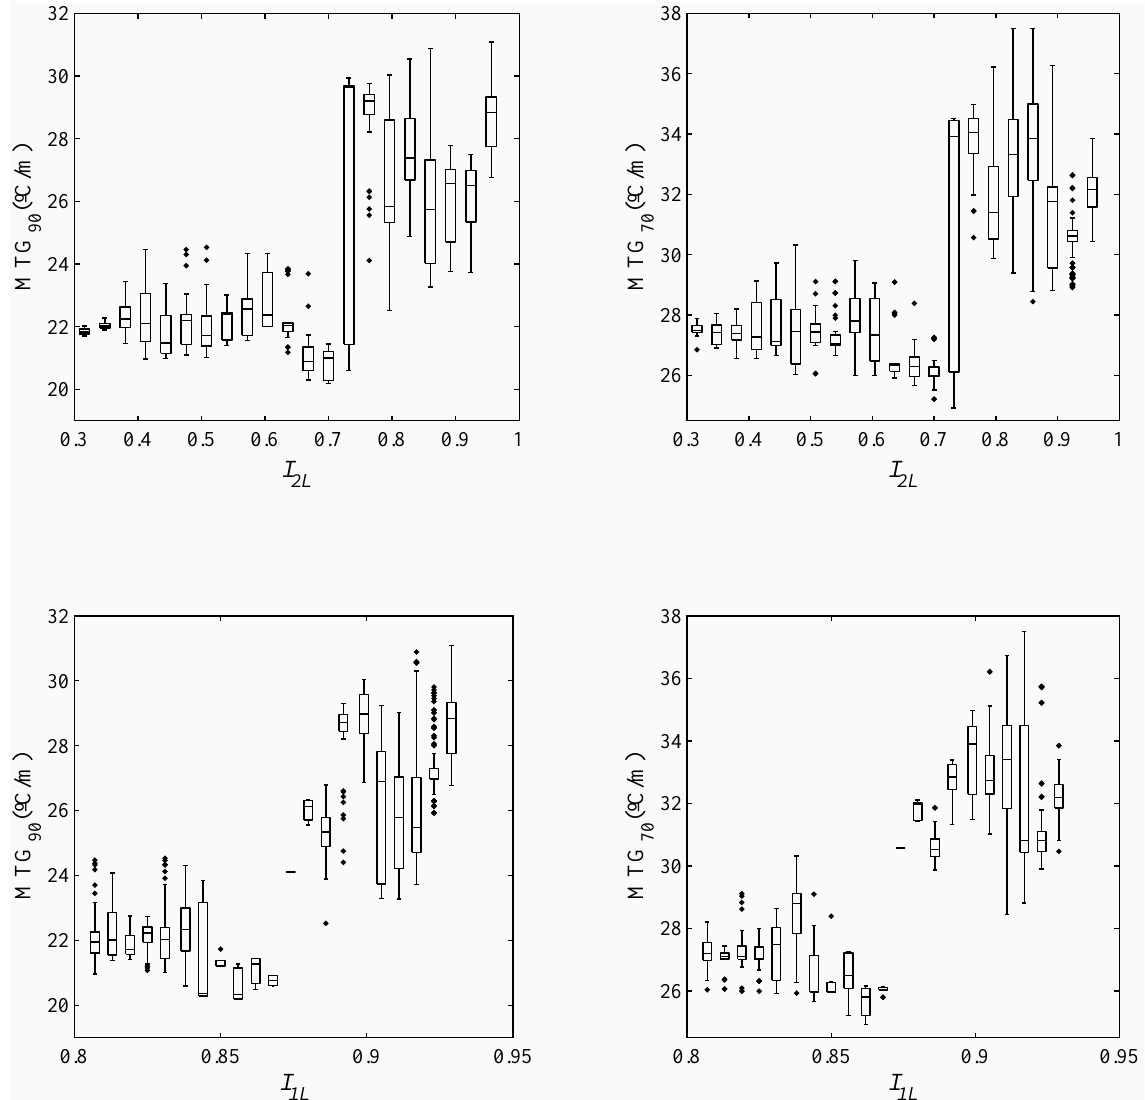
Figure 12. Correlation of Mean Temperature Gradients relative to 90% and 70% of the temperature difference between T hot and T cold against First and Second Law Indices I 1 L and I 2 L